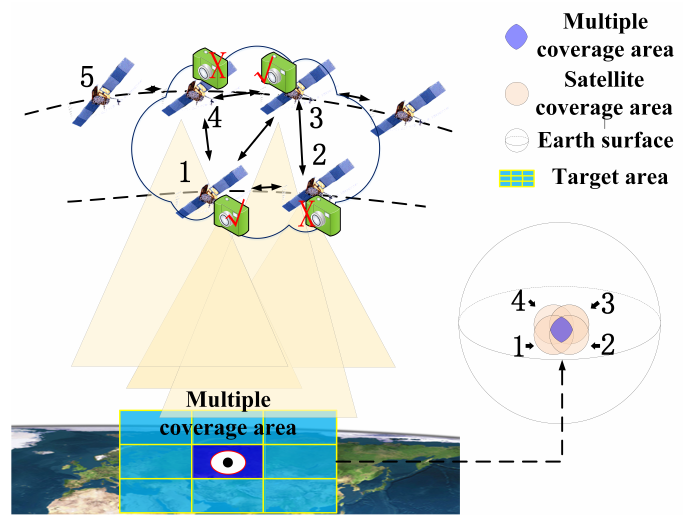
Figure 2. Multiple resource coverages in the target